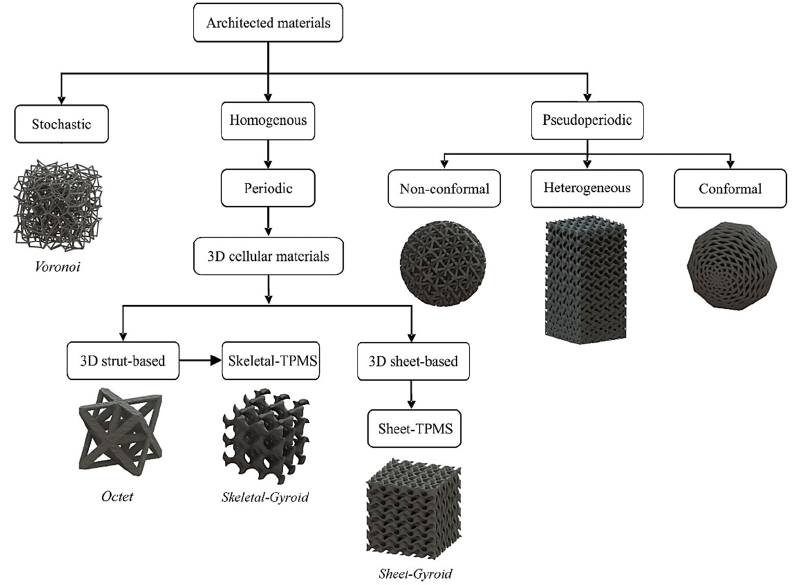
Figure 3. Classification diagram of architected materials with open cells based on the geometry [71,72].